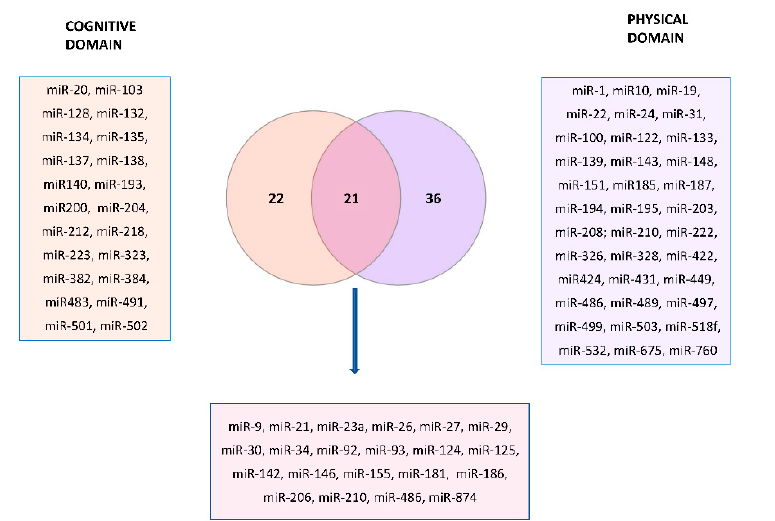
Figure 4. Venn diagram highlighting the (21) miRNAs markers shared between the cognitive and physical domains of frailty (listed in the violet square). The list of markers belonging to the cognitive domain (22) and physical domain (36) is also reported in the pink and indigo squares.